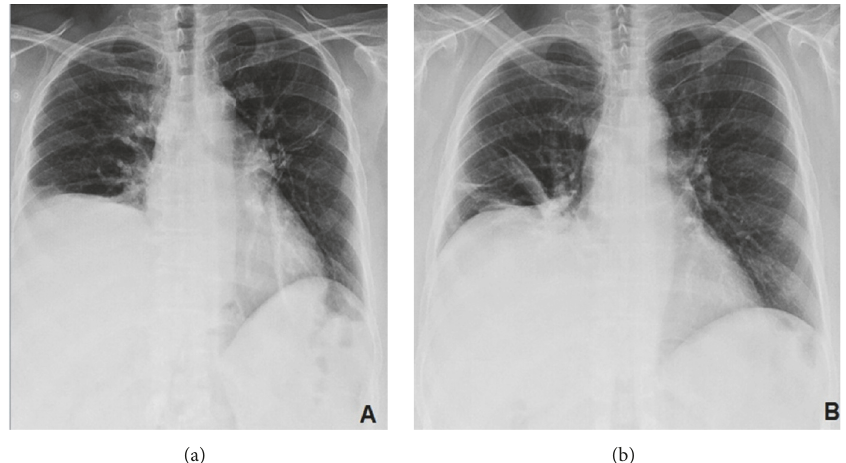
Figure 2: (a) Chest X-ray of the day after the radiofrequency catheter ablation (RFCA) in deep inspiration showing right hemidiaphragm paralyzed. (b) Chest X-ray 6 months after acute event.